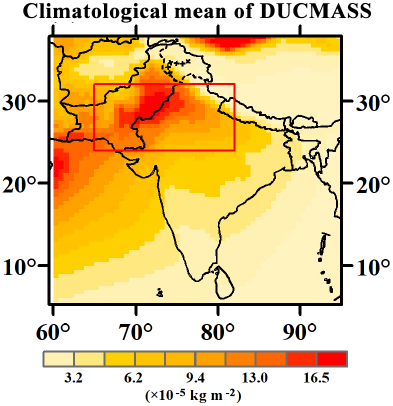
Figure 1. Climatological mean DUCMASS over South Asia based on the MERRA-2 dataset. The dust source over northwestern South Asia is marked with a red